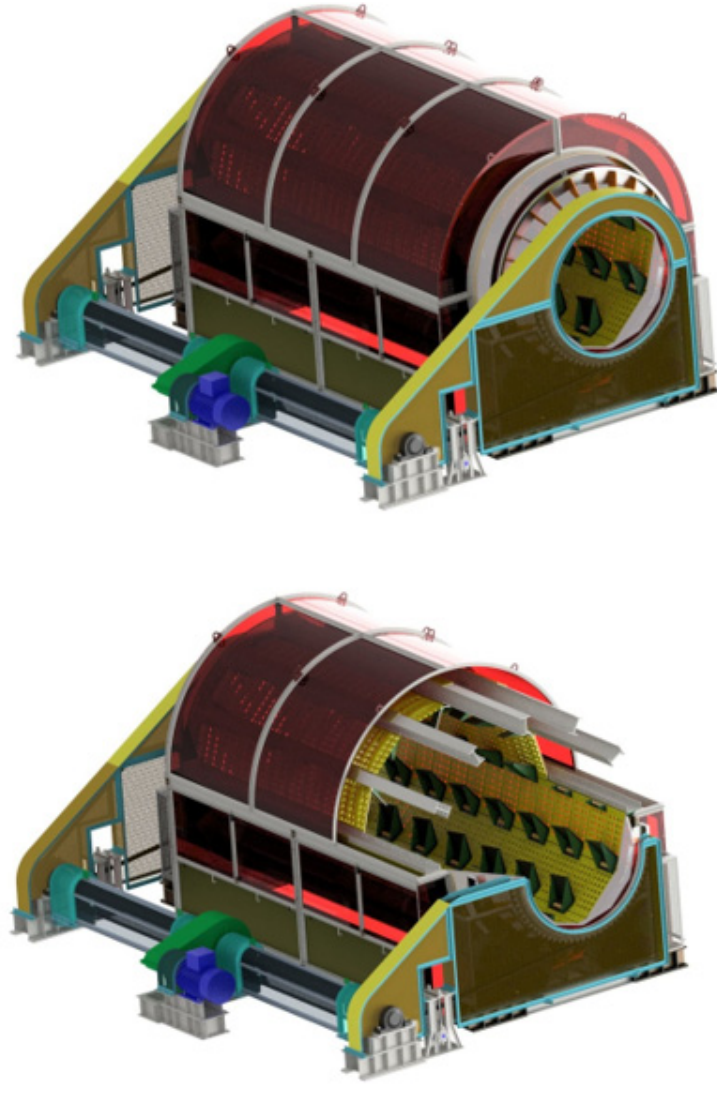
Figure 1. Drum crusher KB 3200 × 6000 (view and section) [20]. Drum crusher’s main component is a drum with a horizontal axis of rotation. Rotation of the drum is forced by two chain gears installed at the inlet and outlet sections. The rotational movement from the motor is transmitted through a cylindrical gear and via two driving shafts, to the sprockets. The center of the drum is lined with screen decks with holes (50–200 mm) depending on the technological requirements. The output grains sent to the crusher move along the drum’s axis and are simultane- ously lifted upwards by lifters installed inside the drum shell.